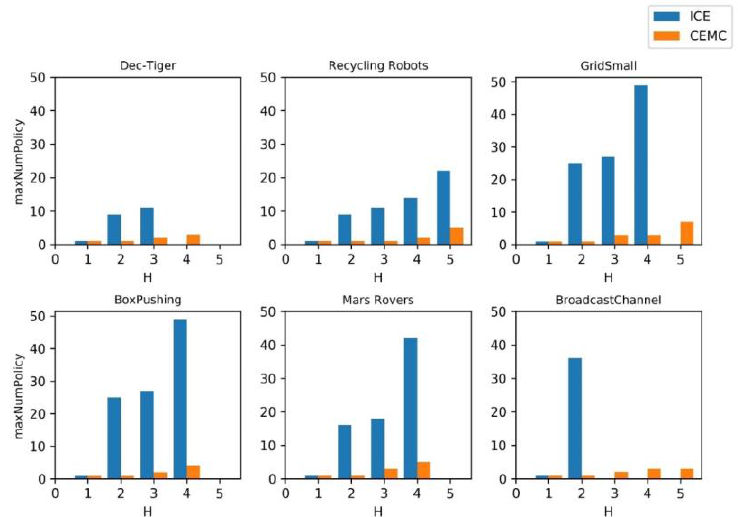
Figure 3. Max number of policies in the policy pool for different horizons. This indicator illustrates that ICE maintains a larger policy pool than CEMC, which may make the former expand useless nodes.